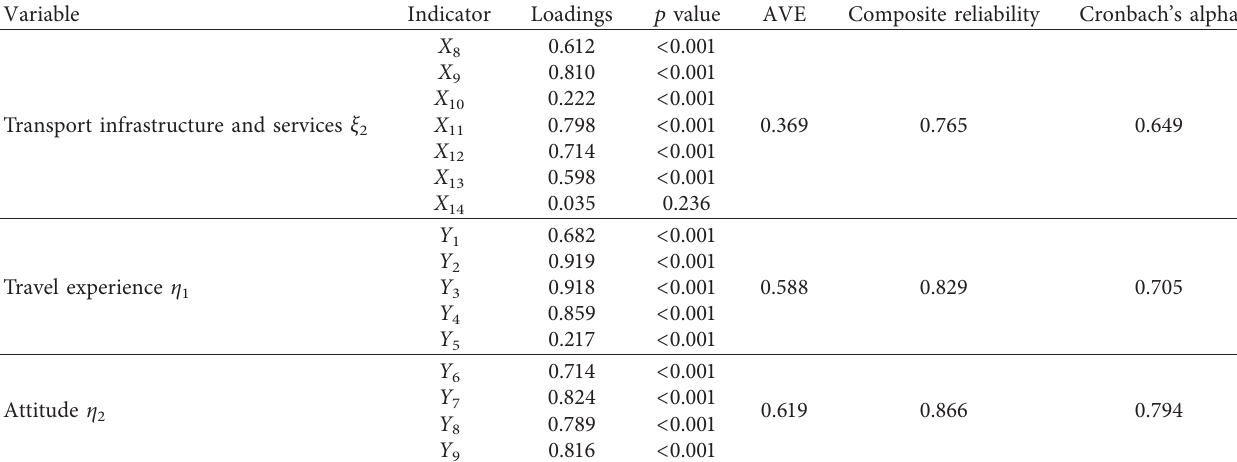
Table 3: Results of convergent validity and reliability